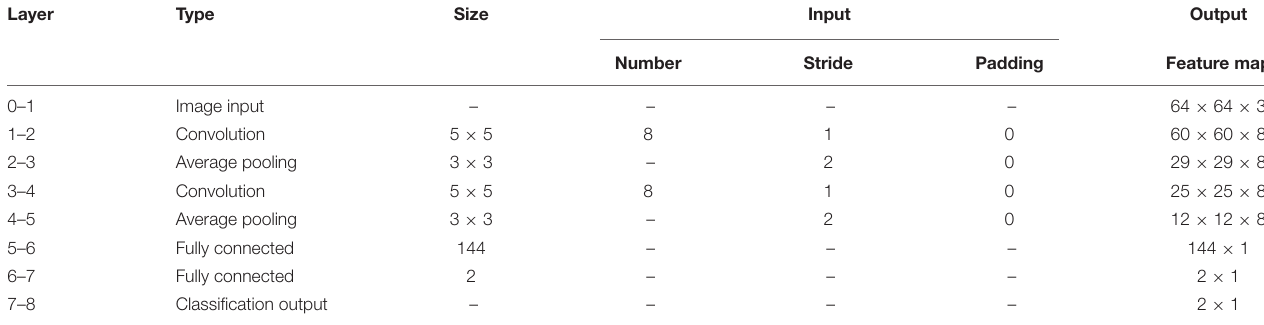
TABLE 2 | Details of the convolutional neural network (CNN) architecture for the proposed computer-aided diagnosis (CAD) system.